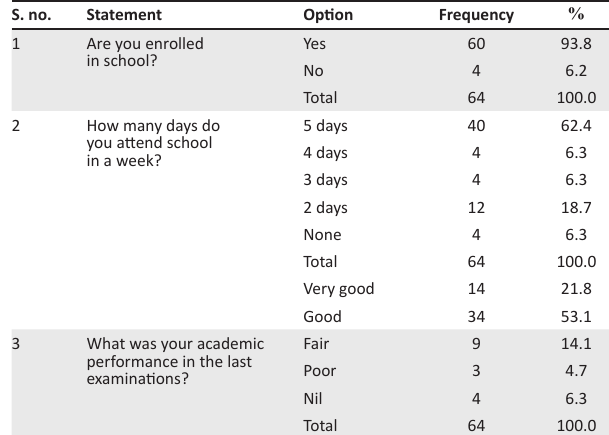
TABLE 2: Distribution of respondents’ responses on school enrolment, attendance and performance. S.